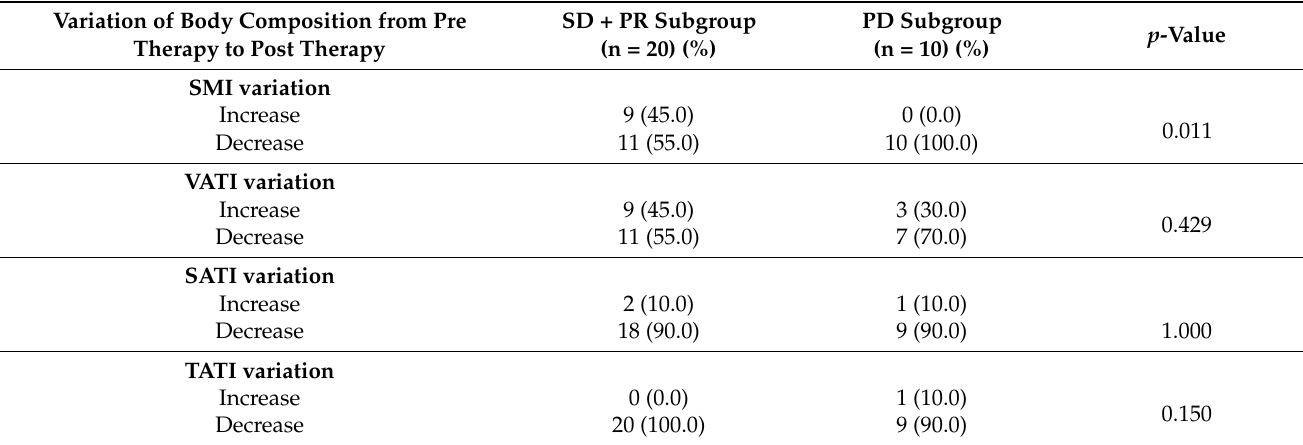
Table 3. Relation among best response and index